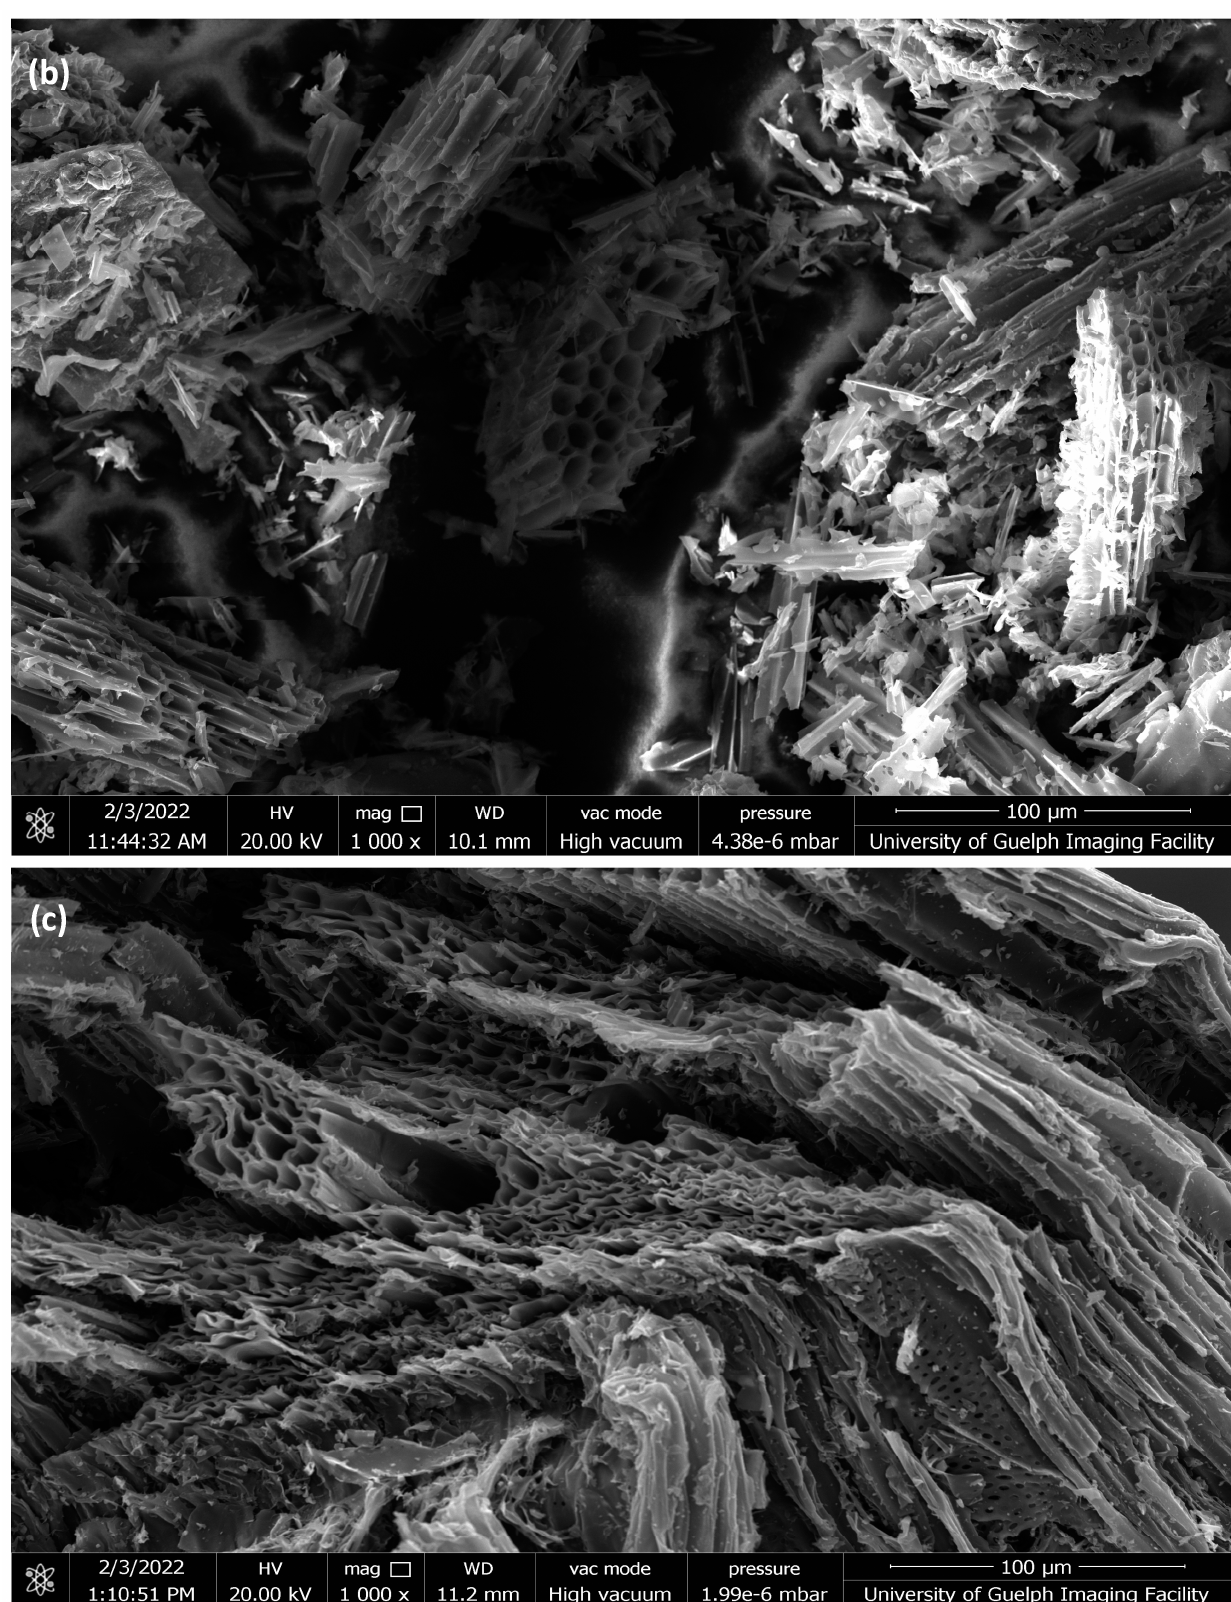
Figure 4. SEM images (200 µm) of hemp biocarbon obtained from pyrolysis at ( a ) 450 °C, ( b ) 550 °C, and ( c ) 650 °C, respectively.